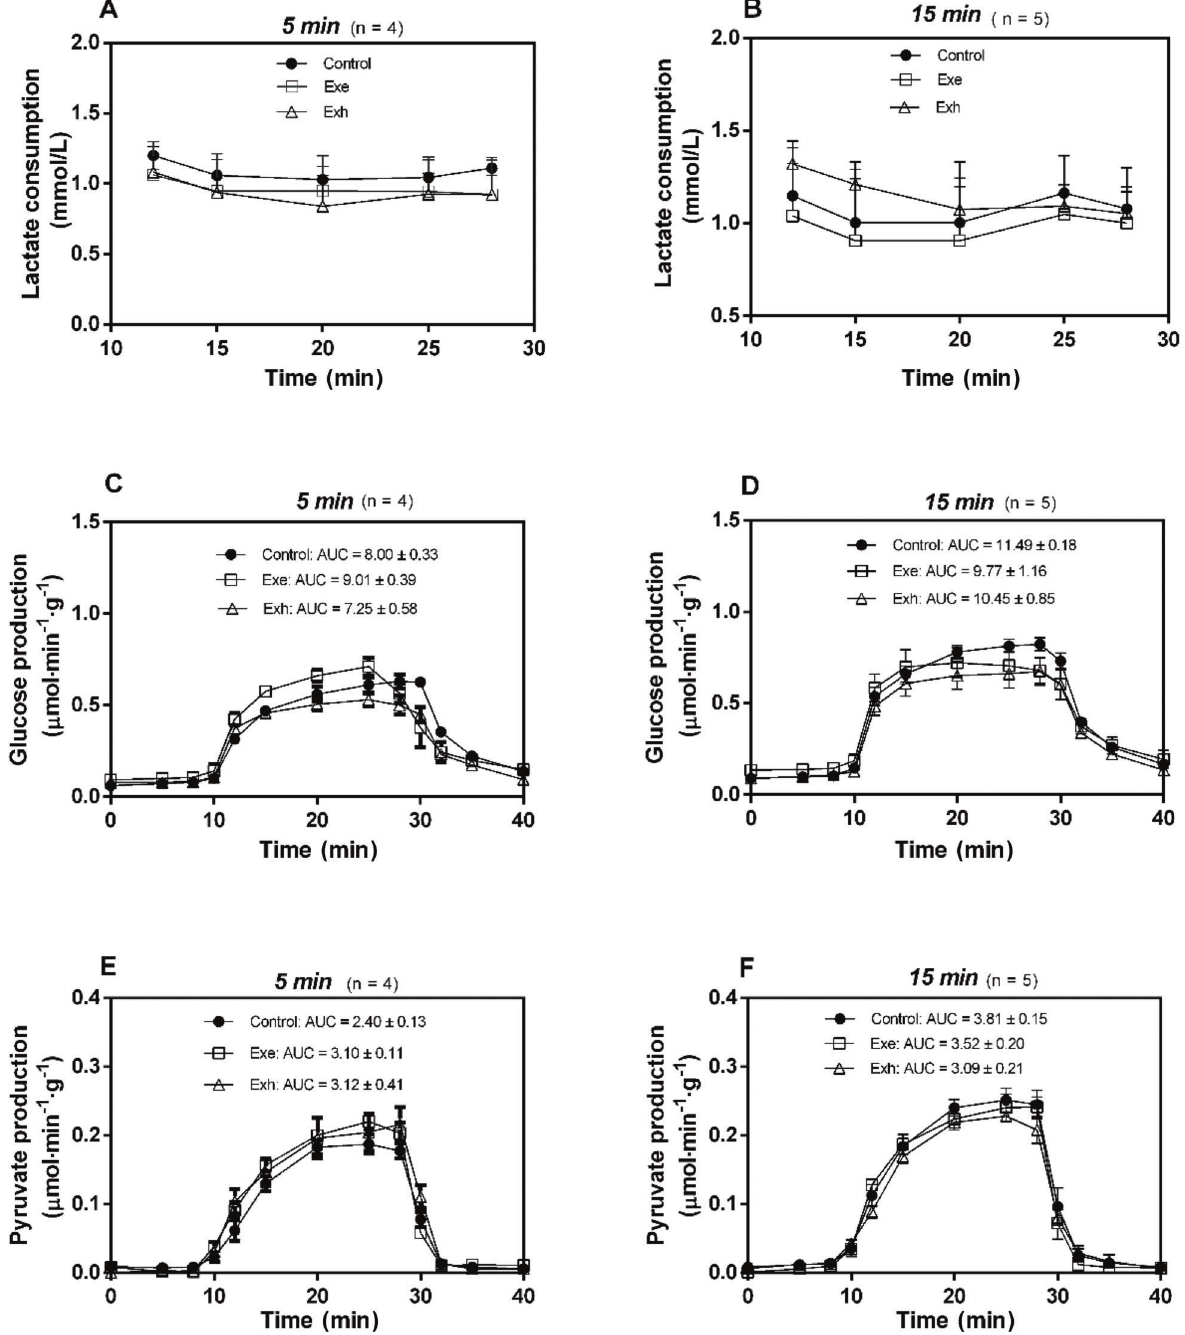
Figure 2. Lactate consumption ( A and B ), glucose ( C and D ), and pyruvate production ( E and F ) from lactate (2 mM) infused between 10 and 30 min, in the livers of 15-h fasted rats submitted to 5 or 15 min of forced swimming (Exe) or exhausted (Exh) after 5 or 15 min of forced swimming. The control group was placed in the water and removed immediately before starting swimming. Area under curves (AUC) is reported as m mol/g. Data are reported as means ± SE.